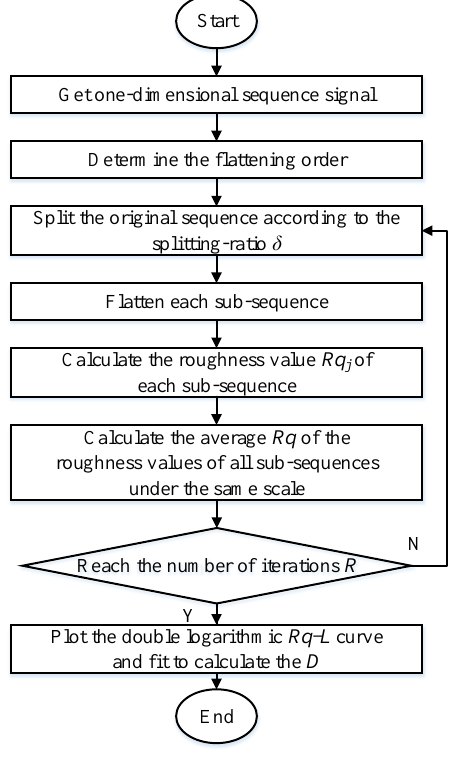
Figure 1. The operation flowchart of the RSE algorithm.